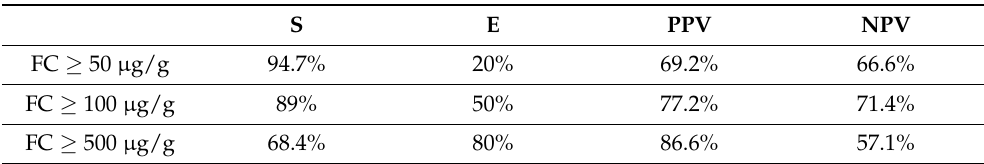
Table 5. Performance characteristics of Fecal calprotectin for the detection of small bowel lesions with Magnetic Resonance Enterography.